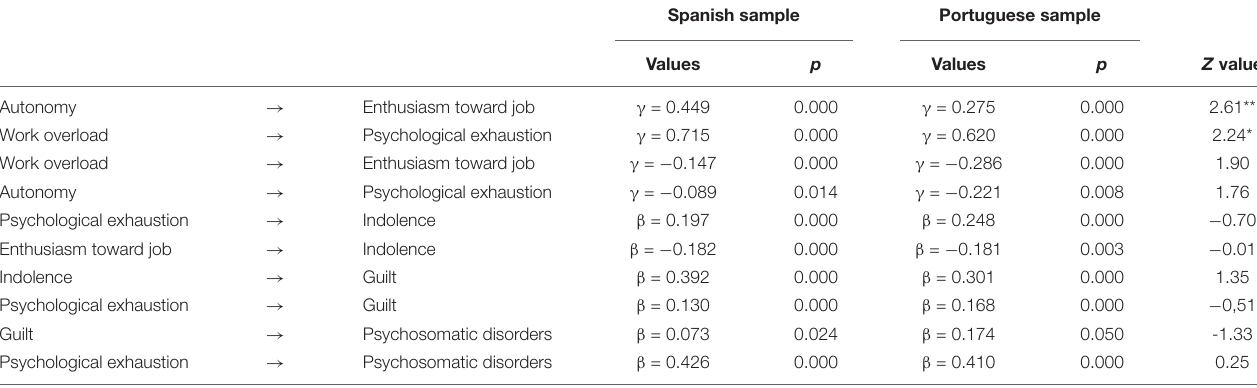
TABLE 3 | Parameters for the relationships among the variables, Z value for the differences and significance